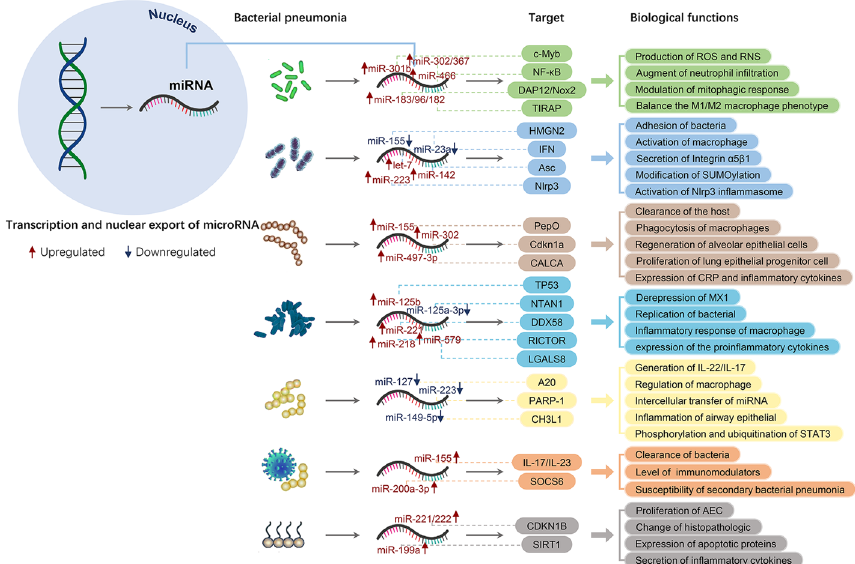
Fig. 4 Examples of miRNAs and their targets and biological functions in bacterial